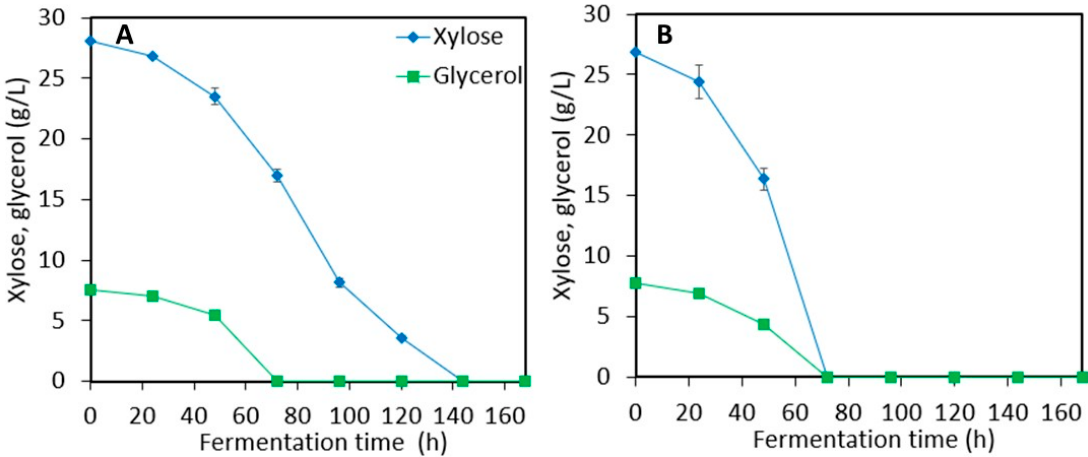
Figure 7. Xylose ( (cid:7) ) and glycerol ( (cid:4) ) consumption by P . rhodozyma in ( A ) non-detoxified stillage media Figure 7. Xylose ( ♦ ) and glycerol ( ■ ) consumption by P . rhodozyma in ( A ) non-detoxified stillage and ( B ) detoxified stillage media and ( B ) detoxified stillage media.